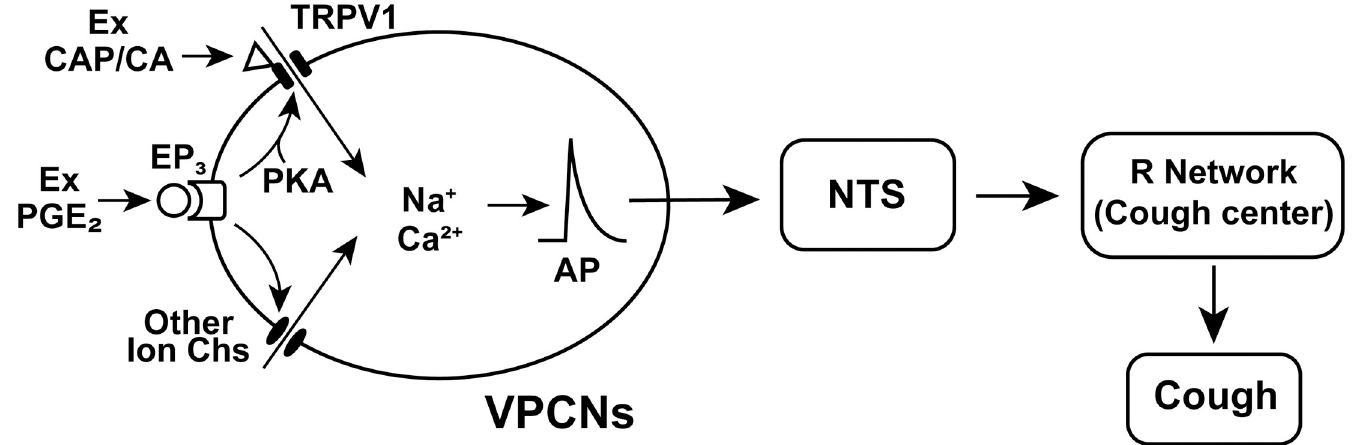
Fig 8. A diagram summarizing the possible pathway of cough responses mediated by EP3 receptor (TRPV1). Exogenous (Ex) rather than endogenous PGE 2 activates EP3 receptor of vagal pulmonary C-neurons (VPCNs) to sensitize/stimulate TRPV1 via the PKA signaling pathway and other ion channels (Chs), while CAP/ CA directly activates TRPV1. Once TRPV1 is activated, sodium and calcium ions flowing through TRPV1 into the neuron to cause depolarization, leading to action potential (AP) firing upon the activation of voltage-gated sodium channels. In addition, PGE 2 may also act on other ion channels to contribute to the neural excitation. The evoked action potentials transmit in vagal afferents to promote the release of excitatory amino acids from the central terminals that stimulate the second-order neurons mainly within the nucleus tractus solitarius (NTS). These neurons further project to the respiratory network (R network) to reflexively elicit cough.